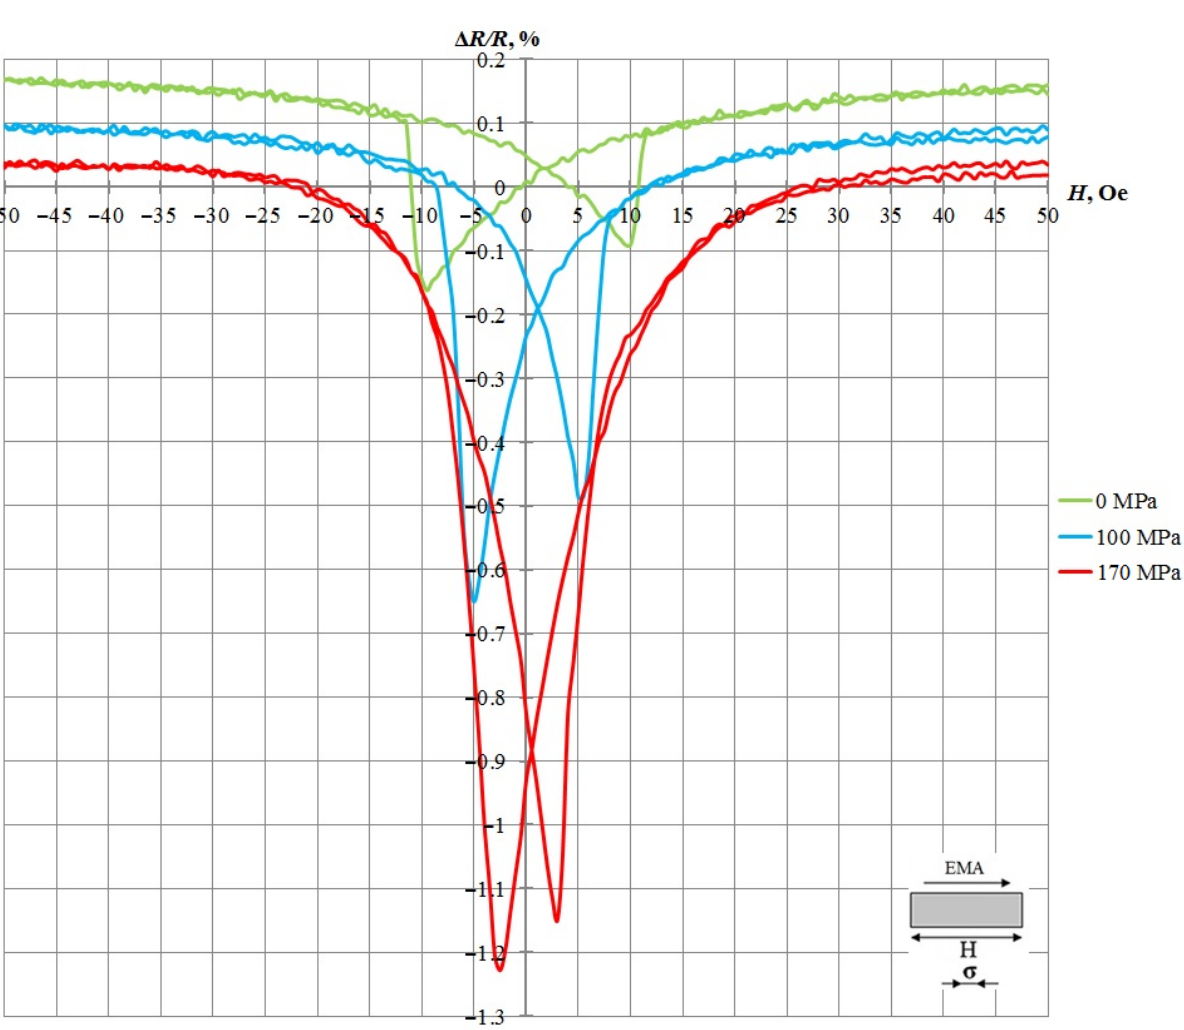
Figure 4. Results of measurement of the AMR effect with and without mechanical load. For the studied sample in the absence of mechanical load, the AMR effect of 0.28 was determined at a coercive force of 9.5 Oe. Under the influence of mechanical compression deformation of 170 MPa, the AMR effect increased to 1.22, and the value of the coercive force was 2.6 Oe. Thus, the relative change in resistance due to the load ( ∆ R/R ) σ is 0.94. Figure 5 shows the dependence of the magnetoresistance due to the mechanical load ( ∆ R/R ) σ on the value of the mechanical compression stress for five samples of FeNiCo/CoFe- type nanostructure, with EMA along the long